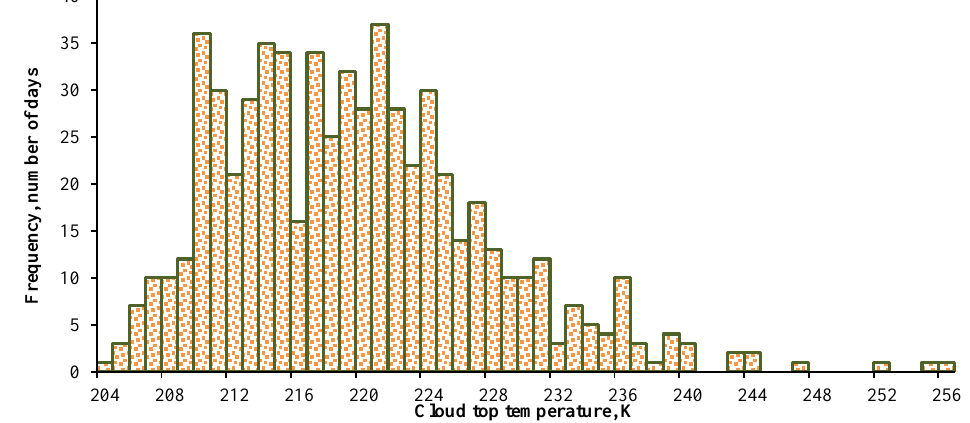
Fig. 6. The frequency distribution of CTT (K) identified from IR 10.8 spectral channel of the SEVIRI instrument aboard the Meteosat satellites on days with more than 10 lightning flashes detected in Latvia over the period